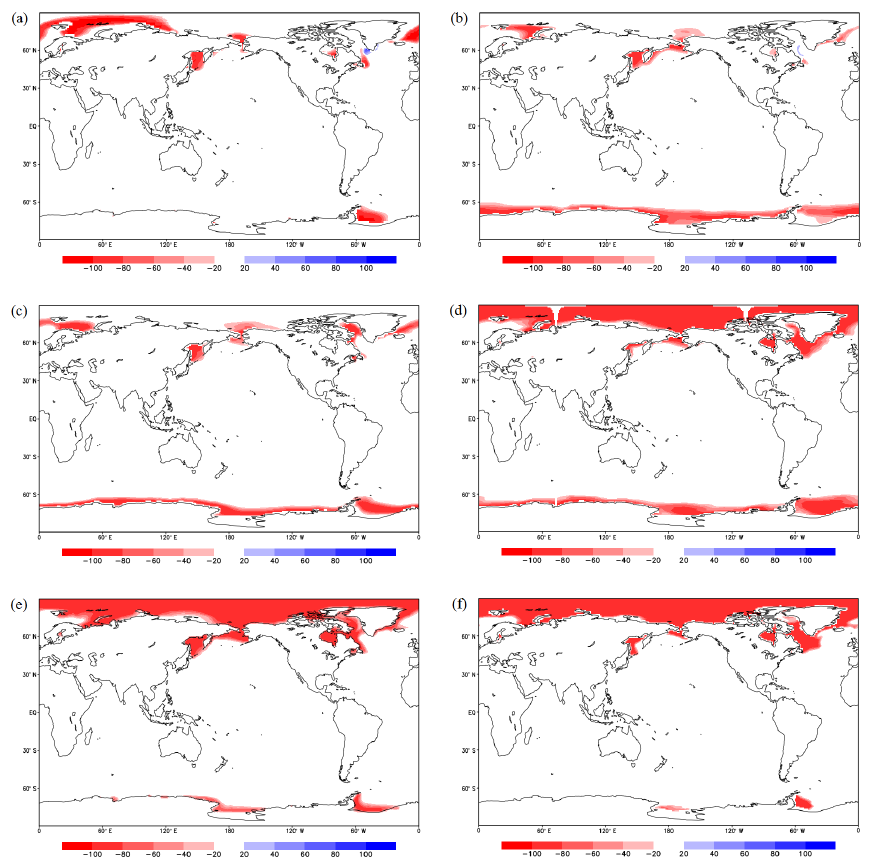
Figure 5. Sea ice concentration for the last 30 years of the Abrupt-4 × CO 2 numerical experiment minus the last 30 years of the piControl run for the following models: (a) BESM-OA V2.5, (b) NCAR-CCSM4, (c) FGOALS-S2, (d) CanESM5, (e) HadGEM2-ES and (f) EC-Earth3- Veg in March (left column).